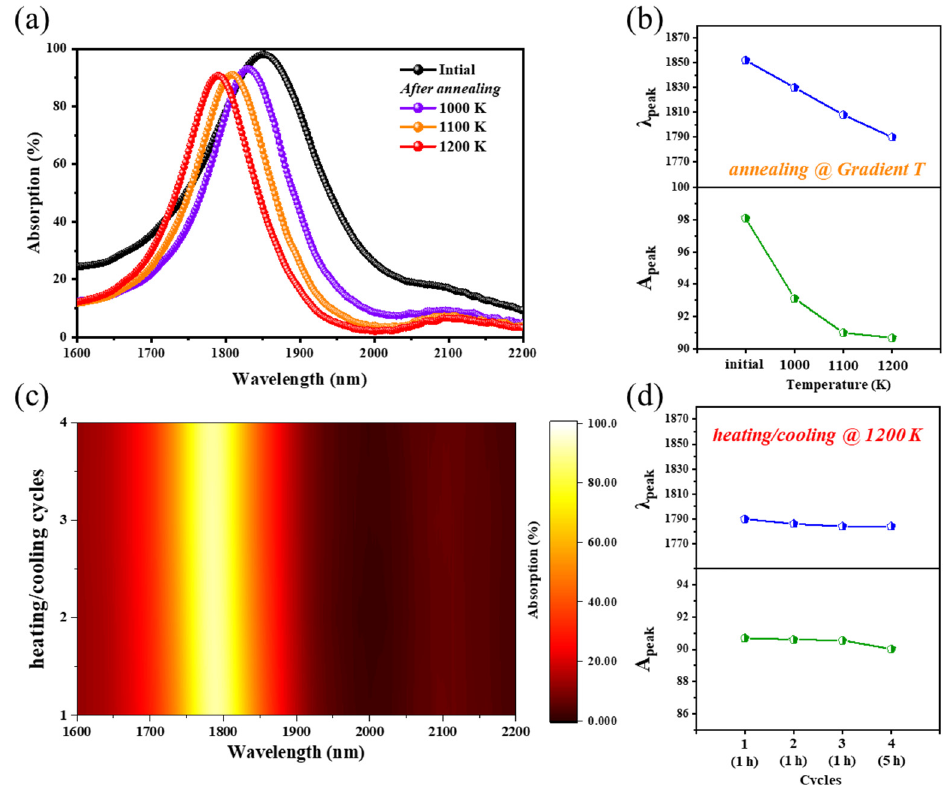
Figure 5. ( a ) Experimental optical absorption spectra of fabricated Si-W-SiN/SiNO emitter before and after annealing at gradient increasing temperature (1000 K, 1100 K, and 1200 K) in Ar atmosphere for 1 h; ( b ) the TPP resonance wavelength ( λ peak ) and the peak value (A peak ) of experimental optical absorption spectra in ( a ); ( c ) experimental 2D absorption maps of fabricated Si-W-SiN/SiNO emitter after heating/cooling for 4 cycles. The first three cycles are annealed at 1200 K in Ar atmosphere for 1 h and the fourth cycle is annealed at 1200 K in Ar atmosphere for 5 h; ( d ) the TPP resonance wavelength ( λ peak ) and the peak value (A peak ) of experimental optical absorption spectra in ( c ).